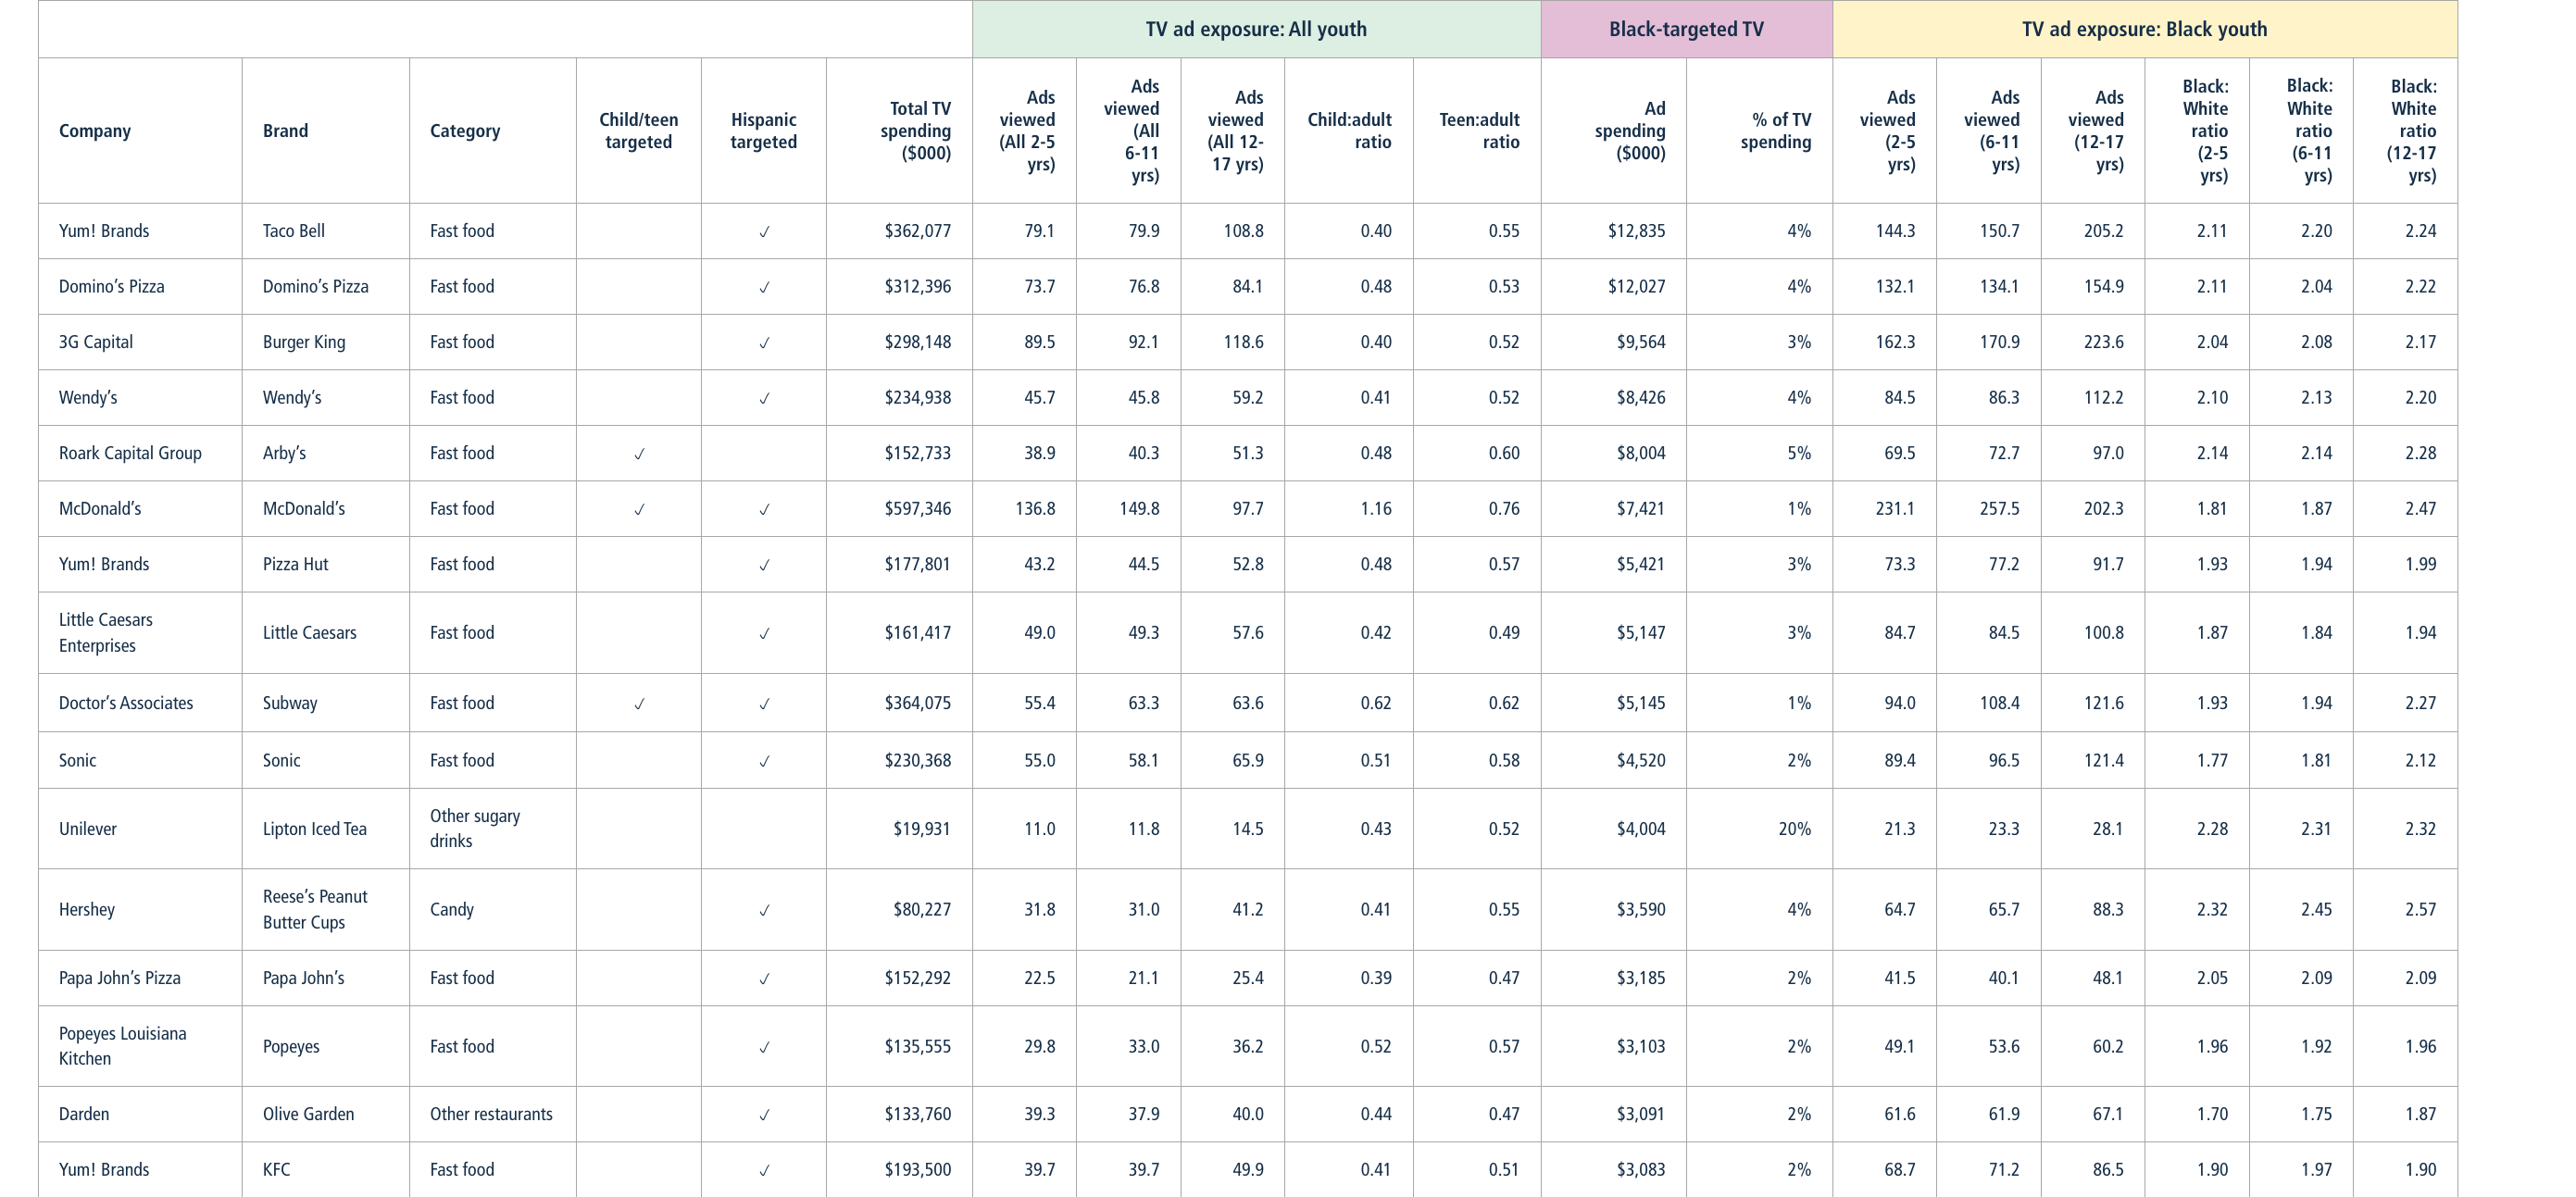
TABLE 3. BRANDS TARGETED TO BLACK